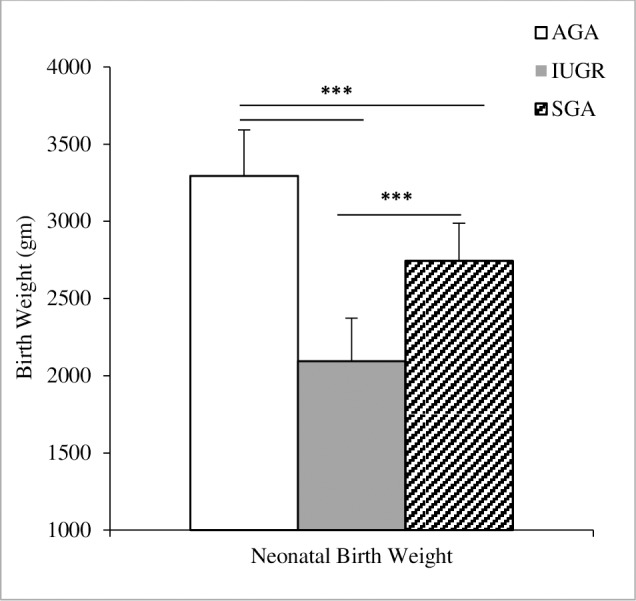
Neonatal birth weights of the three groups.Mean birth weights of the AGA (white), IUGR (grey) and SGA (dashed) groups are presented, significant differences in the birth weight of the AGA compared to the IUGR and SGA (p<0.001). Increased mean birth weight of the SGA compared to the IUGR group (p<0.001). AGA: appropriate for gestational age; IUGR: intrauterine growth restriction; SGA: small for gestational age; Analysis of variance (ANOVA) and posthoc test, *** p <0.001.